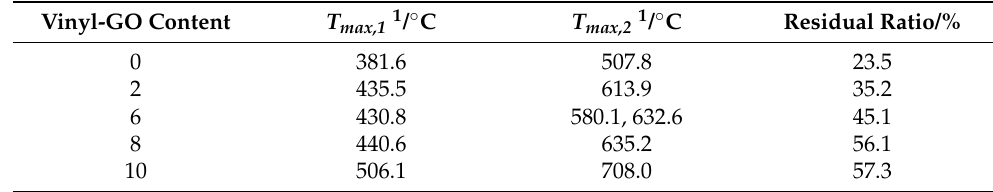
Table 1. TGA data of neat SR and SR/vinyl-GO nanocomposites. Vinyl-GO Content